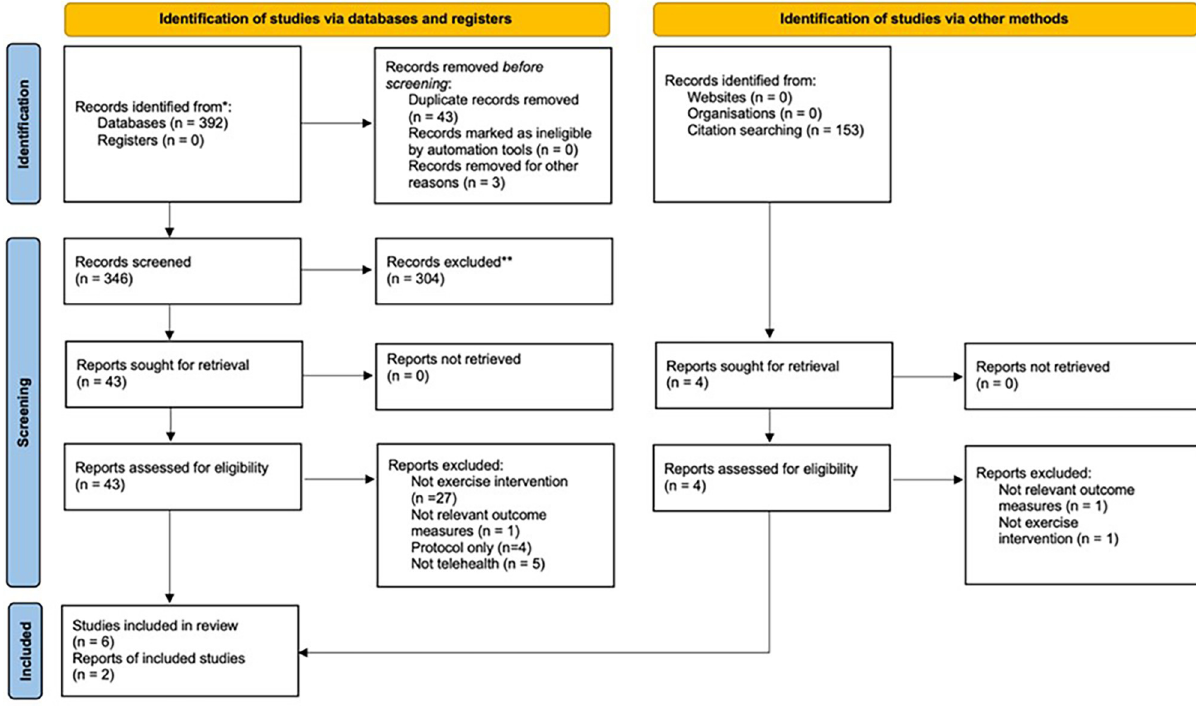
Fig 1. PRISMA Flow Chart